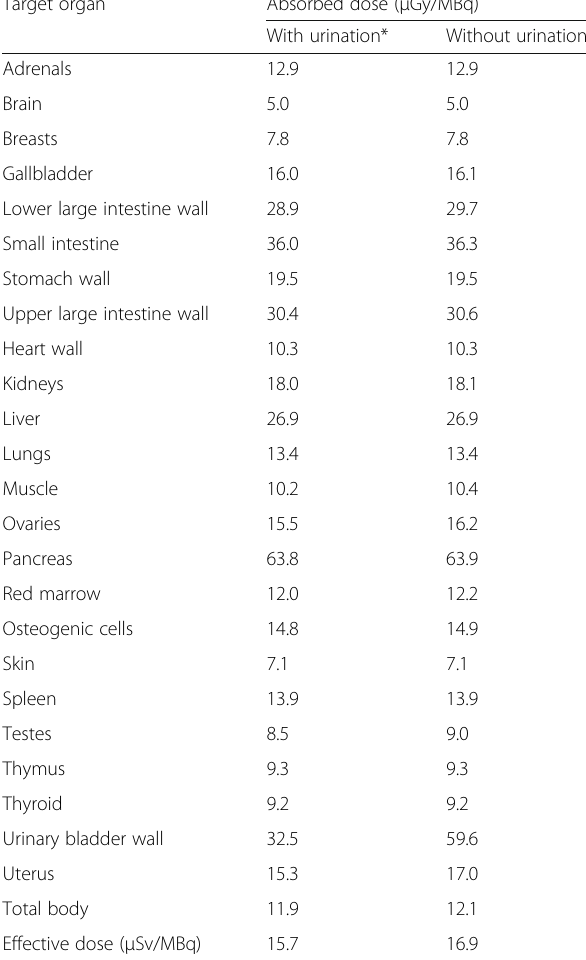
Table 5 Absorbed dose of [ 18 F]MC225 for human adults estimated from mouse